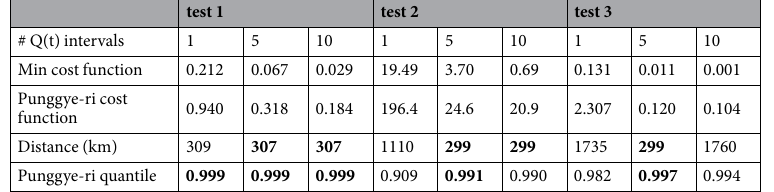
Table 2. Minimum cost function value of the full grid, cost function value at the Punggye-ri nuclear test site and distance between both. The last row shows the quantile of the Punggye-ri cost function compared to all grid boxes in the Eurasia domain (9211 grid points). Values are given for the three fictitious sources and different time resolutions of the source term Q(t). The best values for each test are shown in